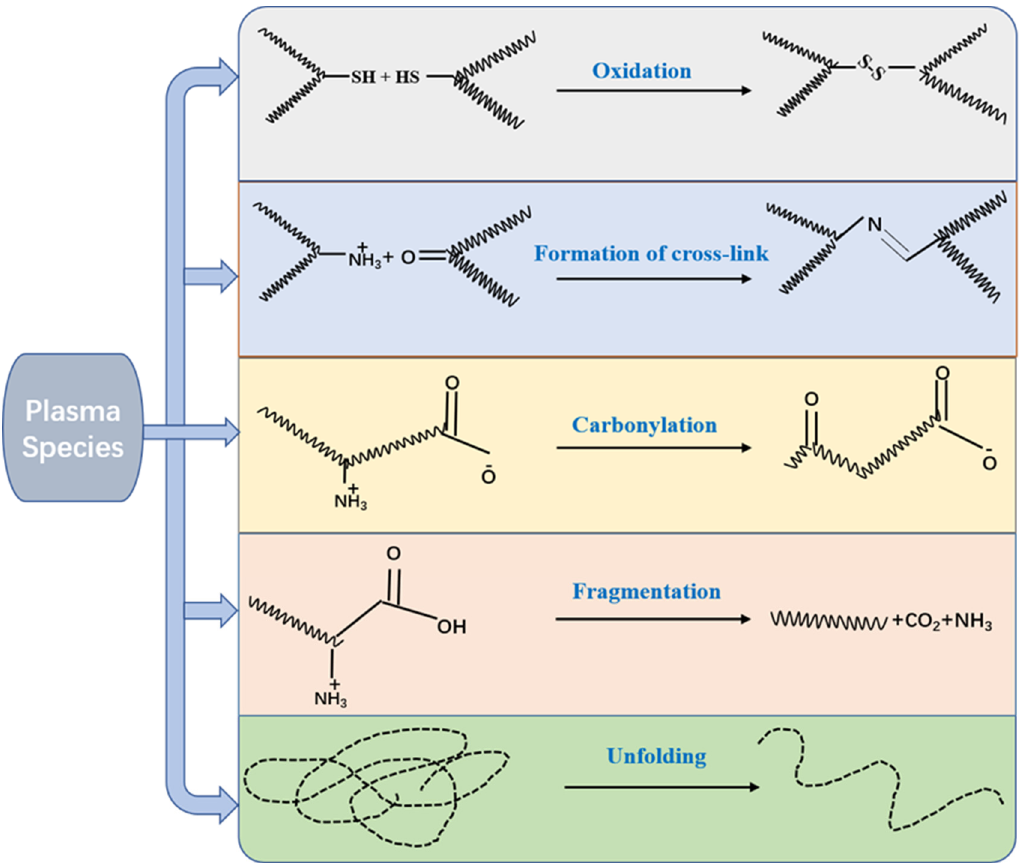
Figure 3. The effect of cold plasma on proteins, adapted from [60].